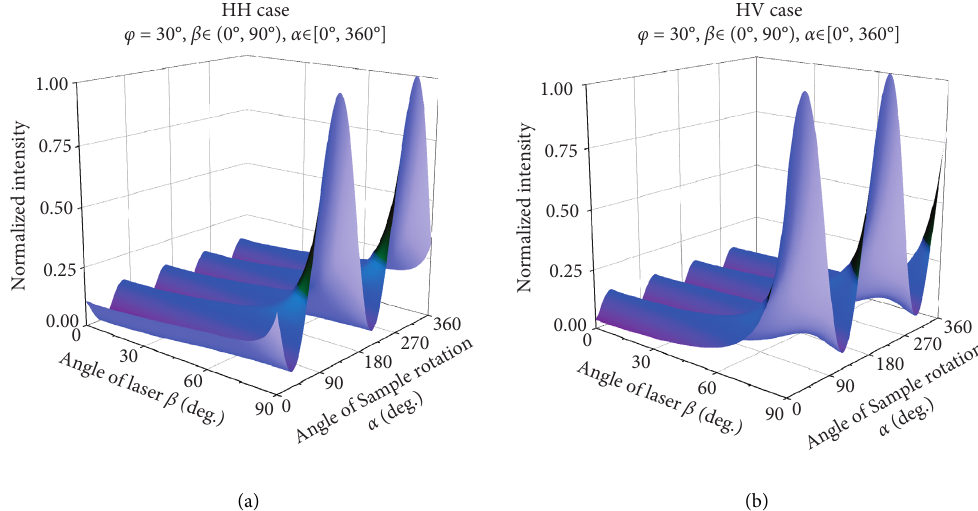
Figure 6: Raman intensity distribution under the oblique backscattering configuration for different inclination angles β and sample rotation angles α when φ � 30 ° in the (a) HH case and (b) HV